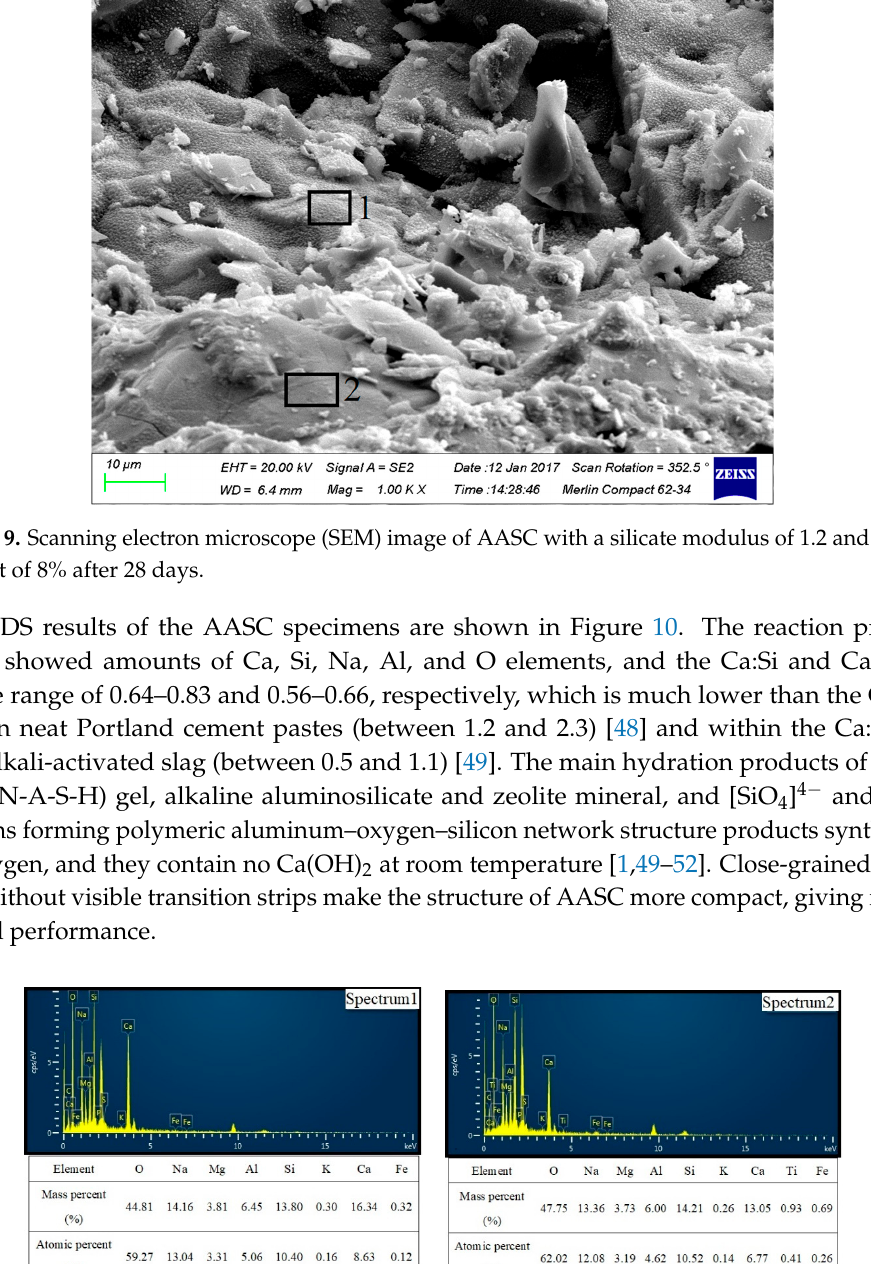
Figure 10. Energy-dispersive spectrometry (EDS) images of AASC with a silicate modulus of 1.2 and Na 2 O content of 8% after 28 days: ( a ) Spectrum 1; ( b ) Spectrum 2.